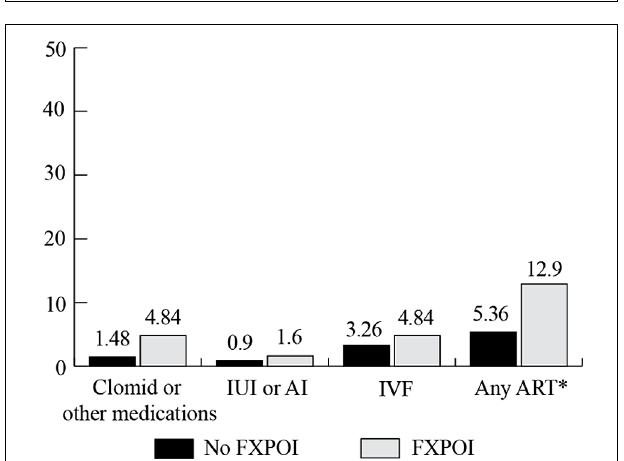
FIGURE 8 | Percentage of women with and without FXPOI endorsing use of reproductive assistance before knowing their FMR1 status. * Significant difference between groups.